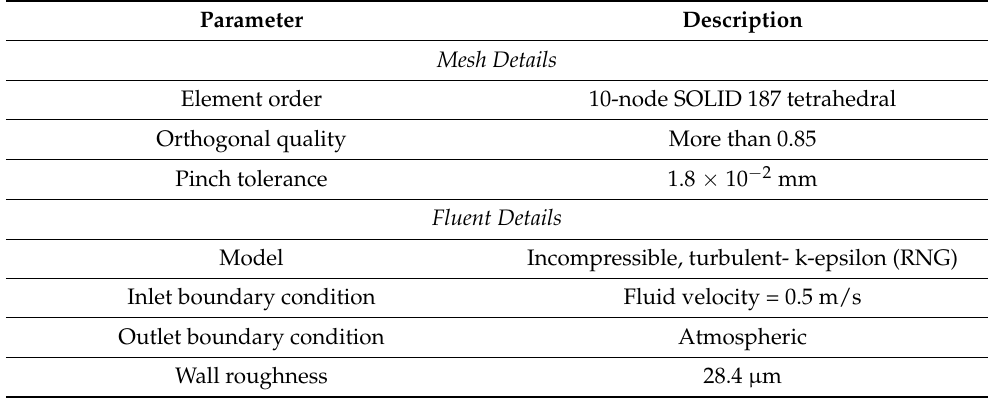
Figure 3. Consolidated computational framework implemented in this study. Table 2. Computational parameters implemented for the slipping simulation.